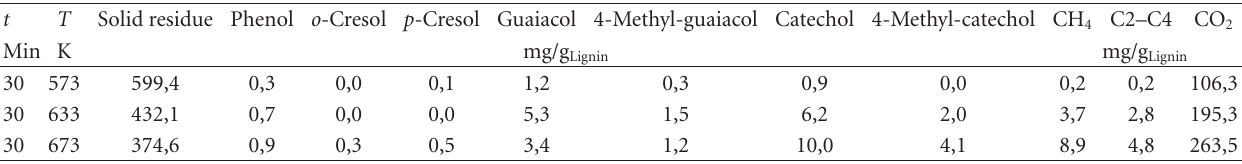
Table 3: Results of hydrothermal lignin degradation experiments, input: 0.4 g lignin, 3g H 2 O.